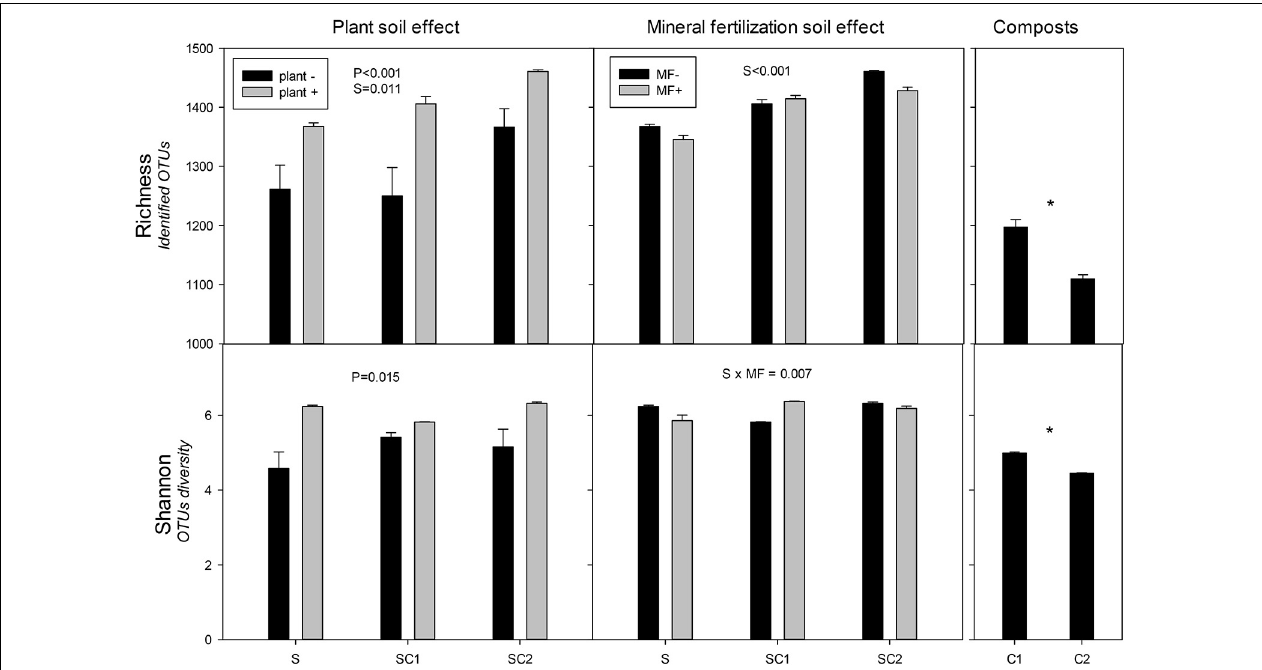
FIGURE 3 | Richness and Shannon index for the identified operational taxonomic units (OTUs) of bacteria in the different soils (S, SC1, SC2) with (plant+) and without plant and in minerally fertilized (MF+) and unfertilized (MF − ) soils (S, SC1, SC2). Data on the original composts (C1 and C2) are also shown. Data represent the means and standard errors of three replicates for each sample. Significant factors of ANOVA are indicated. P, plant effect; S, soil effect; MF, mineral fertilization; S*MF, interaction of soils and mineral fertilization. Asterisk indicates significant differences between the composts.